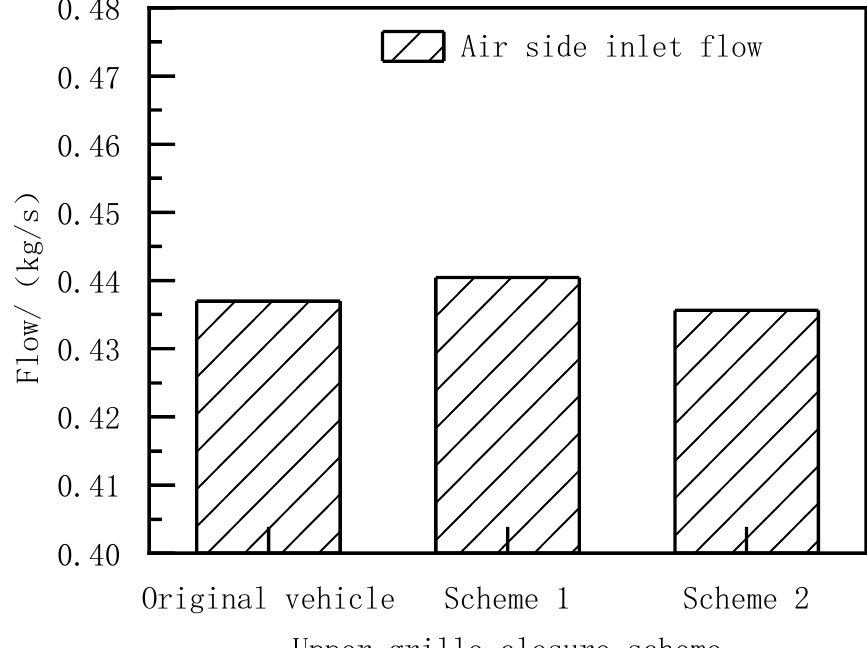
Figure 9. Comparisons of intake air mass flow of radiator under different upper grille schemes.